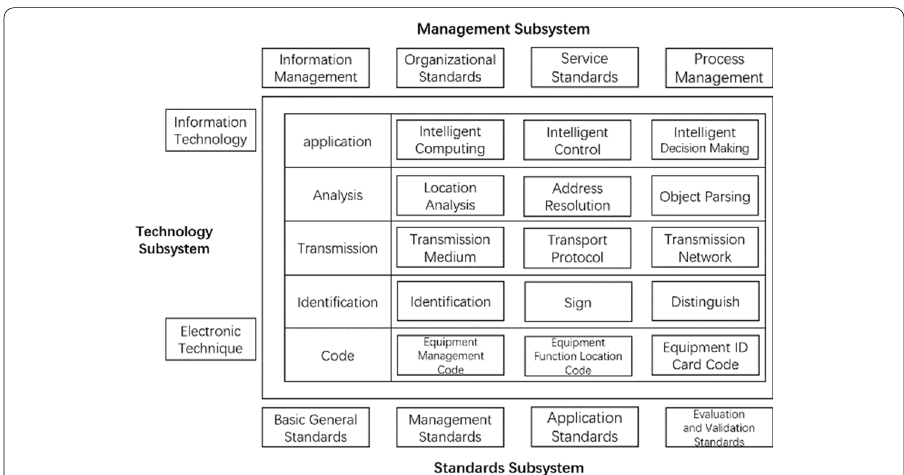
Fig. 2 Framework of unified coding and identification system; Description of o Framework of unified coding and identification